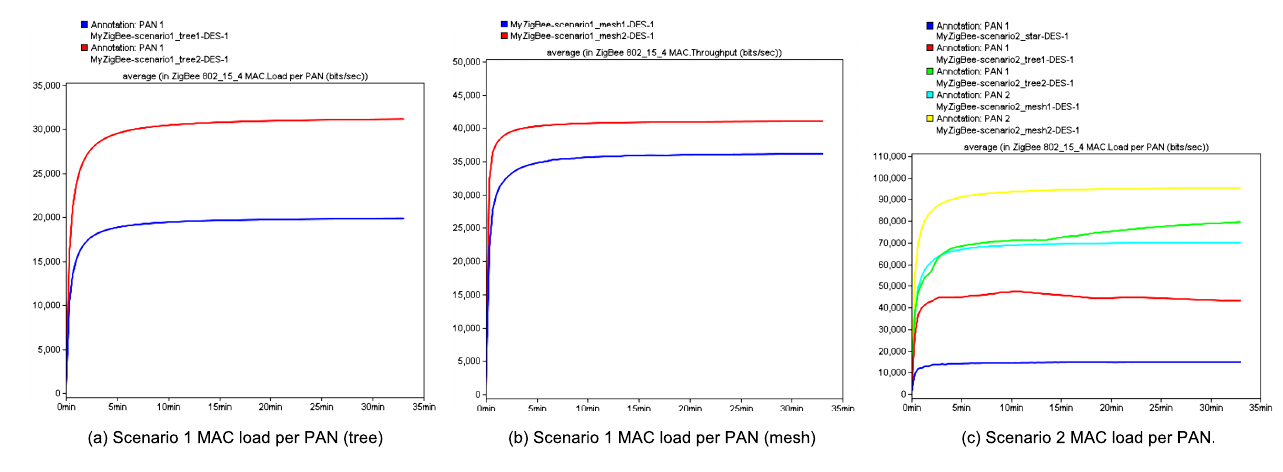
Figure 6. Load per PAN